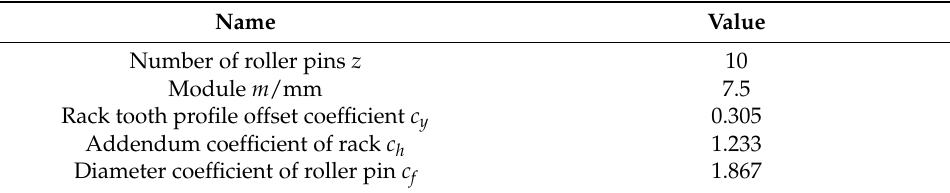
Table 4. Parameters used in meshing stiffness